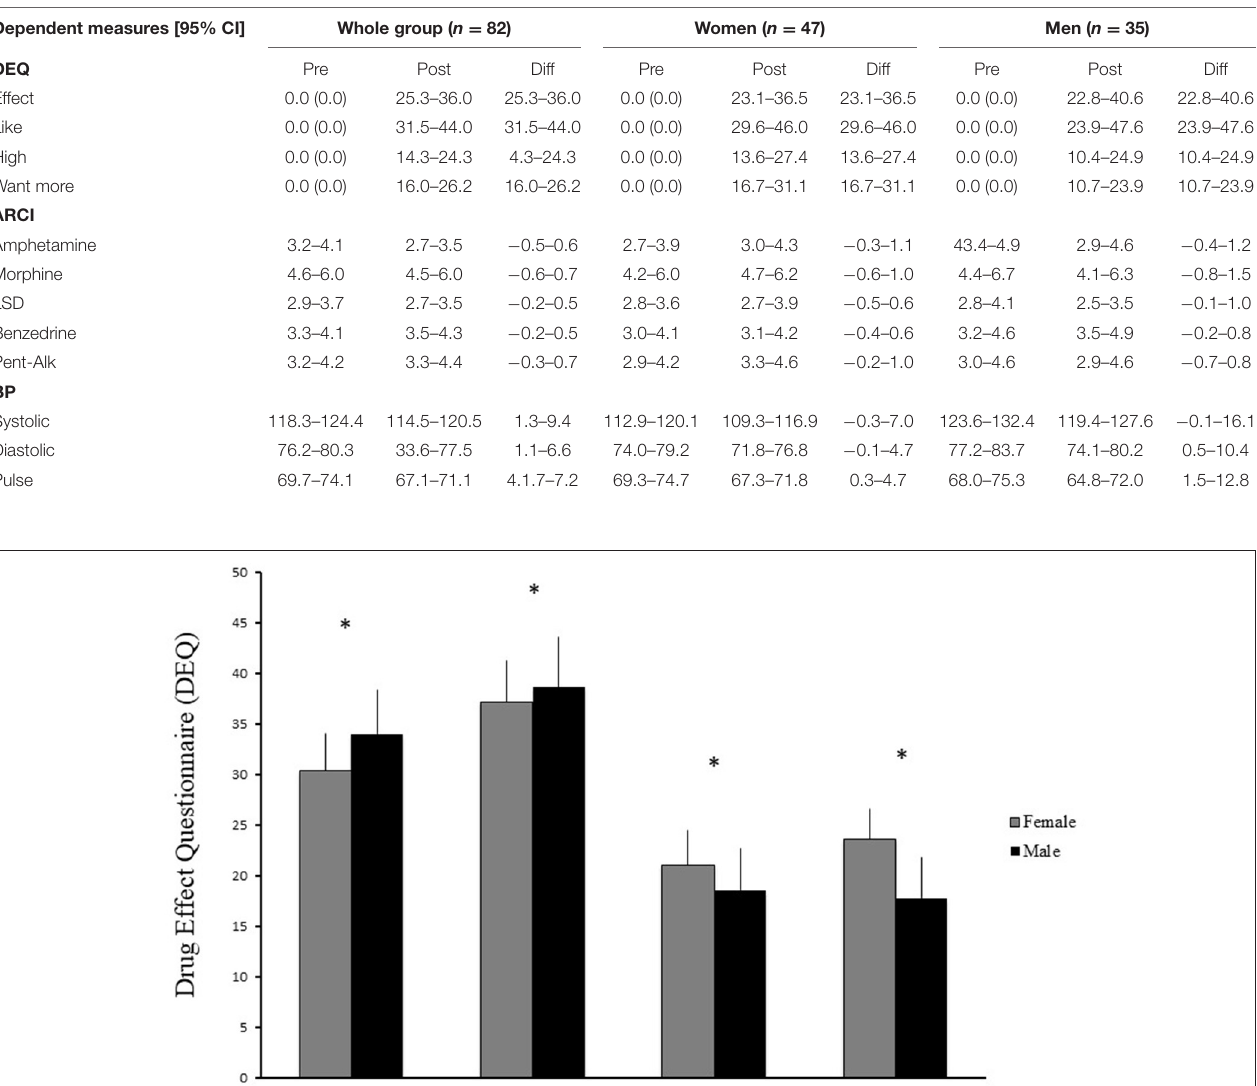
TABLE 3 | Confidence Intervals are presented as pre-test, post-test, and difference score for all dependent measures taken in the study in data on whole group, women and men.